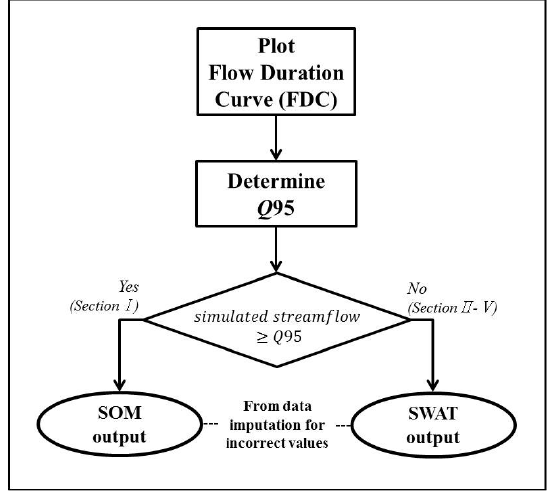
Figure 7. The proposed data imputation algorithm using SOM and the SWAT model.